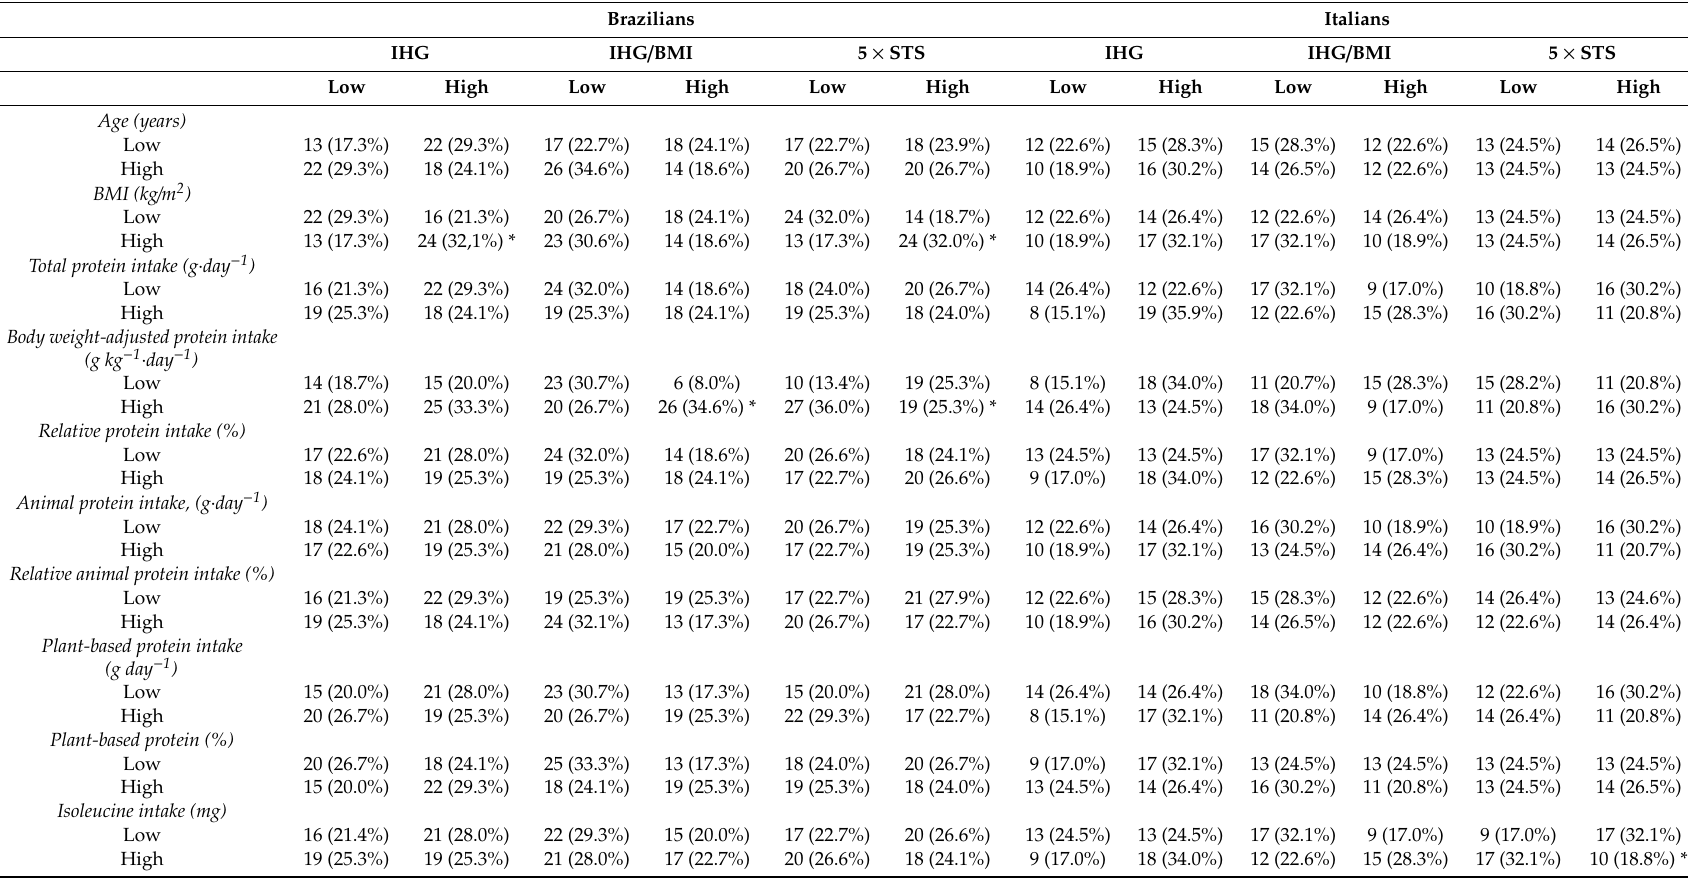
Table 2. Distribution of Brazilian and Italian older women according to physical function levels (low vs.